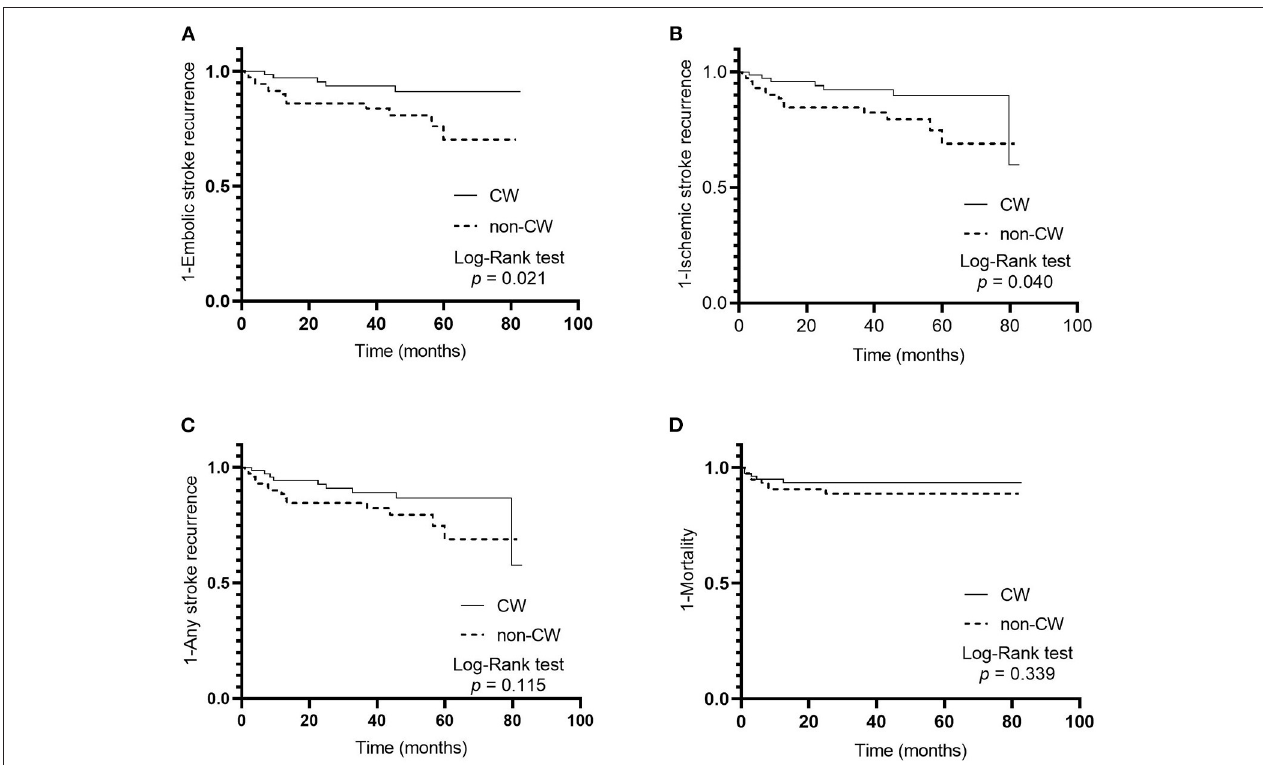
FIGURE 3 | Cumulative probability of primary and secondary outcomes in patients with embolic stroke of undetermined source and atrial cardiopathy according to left atrial appendage morphology; embolic stroke recurrence (A) , ischemic stroke recurrence (B) , any stroke recurrence (C) , and mortality (D) .